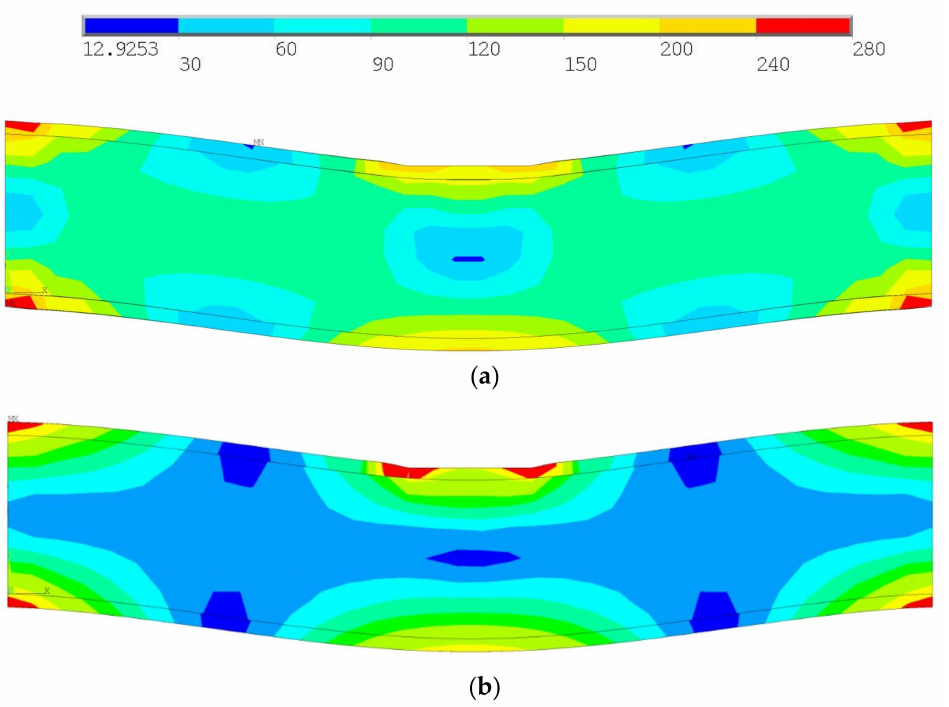
Figure 3. Von Mises stress distribution for initial ( a ) and structurally designed ( b ) beam.